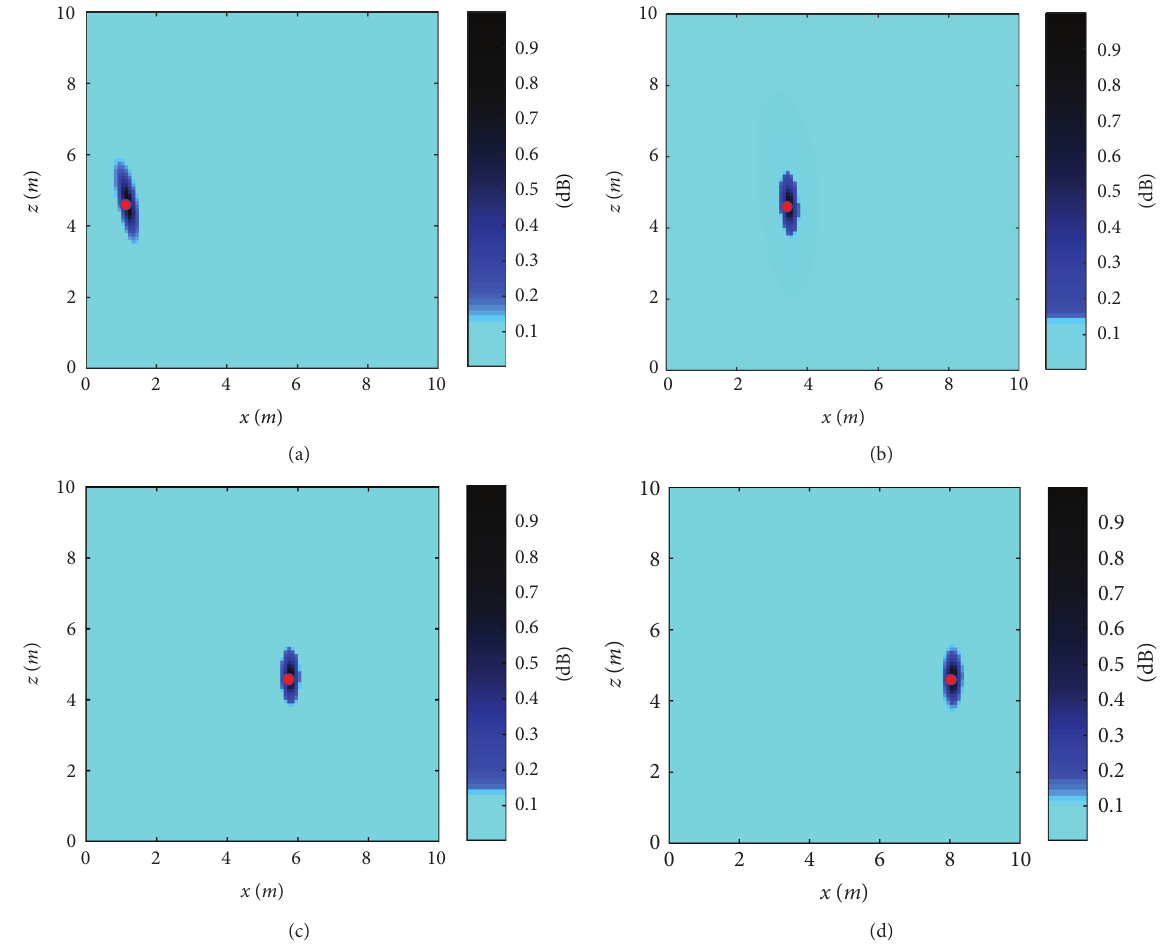
Figure 12: Acoustic maps of partition array in different seconds: (a) 0.47s; (b) 0.49s; (c) 0.51s; (d)